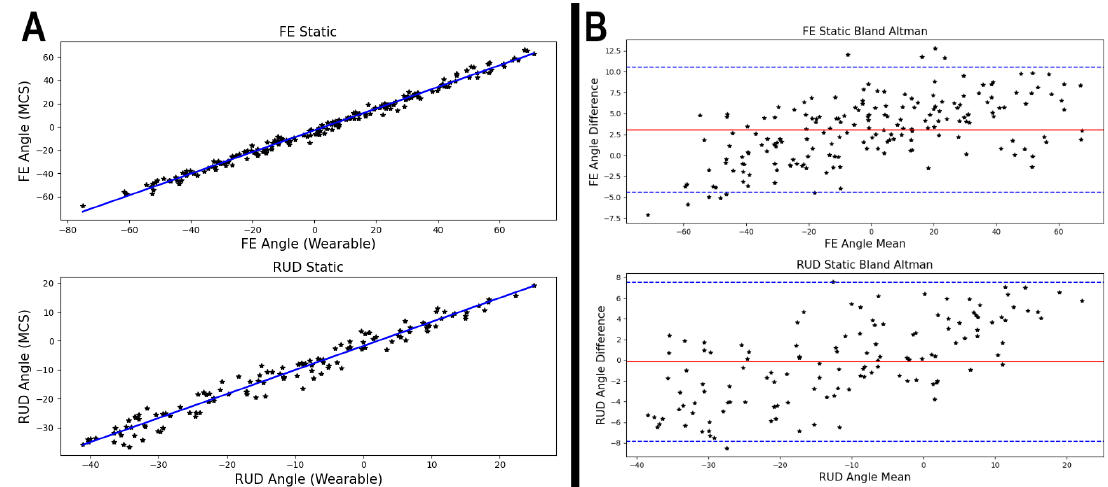
Figure 7. Correlation between wearable and optical motion capture (OMC) for flexion/extension (FE) and radial/ulnar deviation (RUD) ( A ) mean-difference plots quantifying agreement between the wearable and OMC for FE and RUD ( B ). Each point represents one